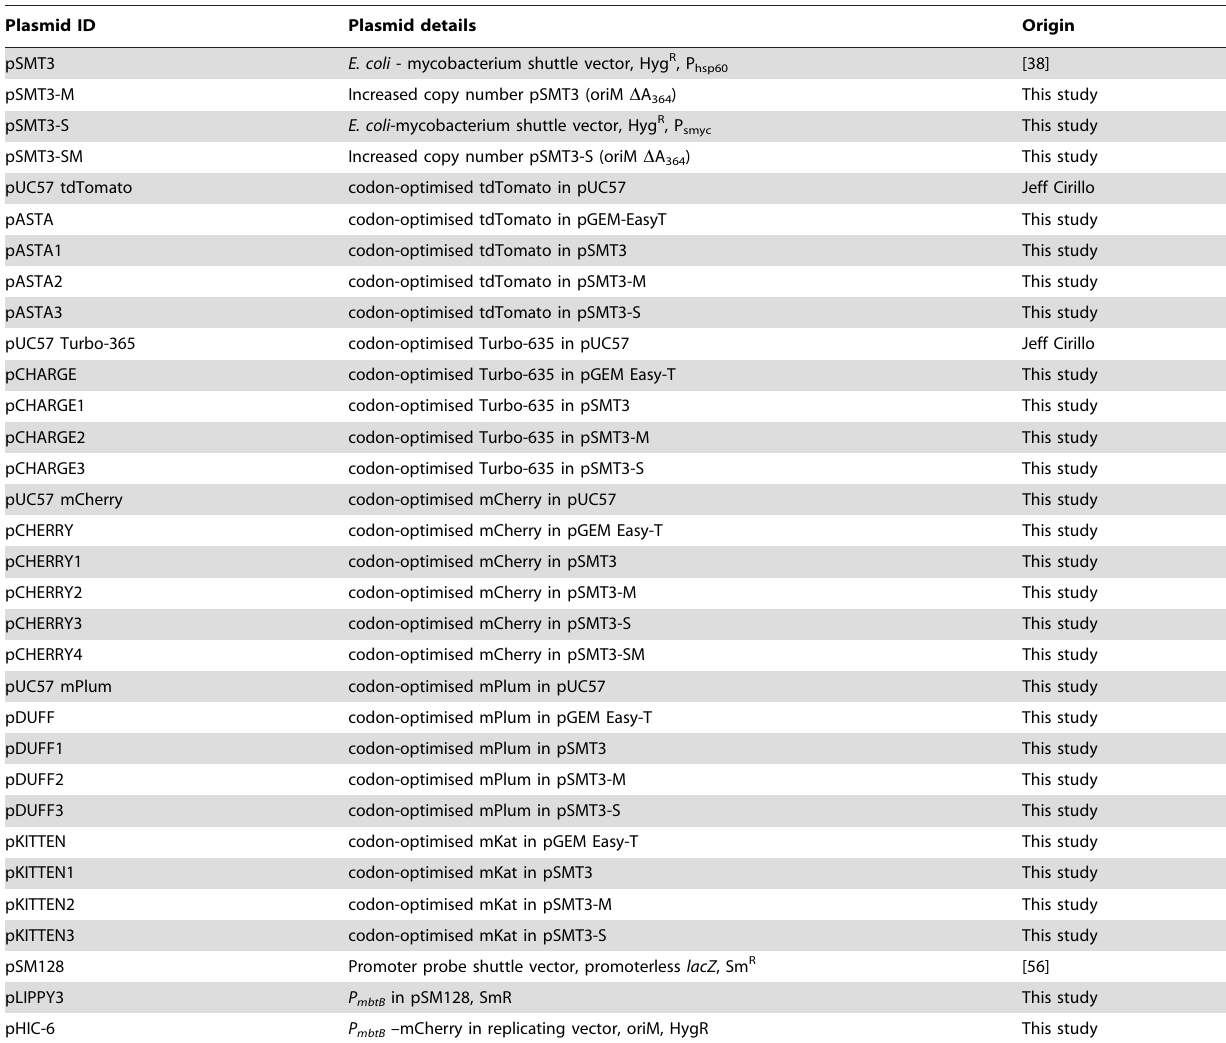
Plasmid ID Plasmid